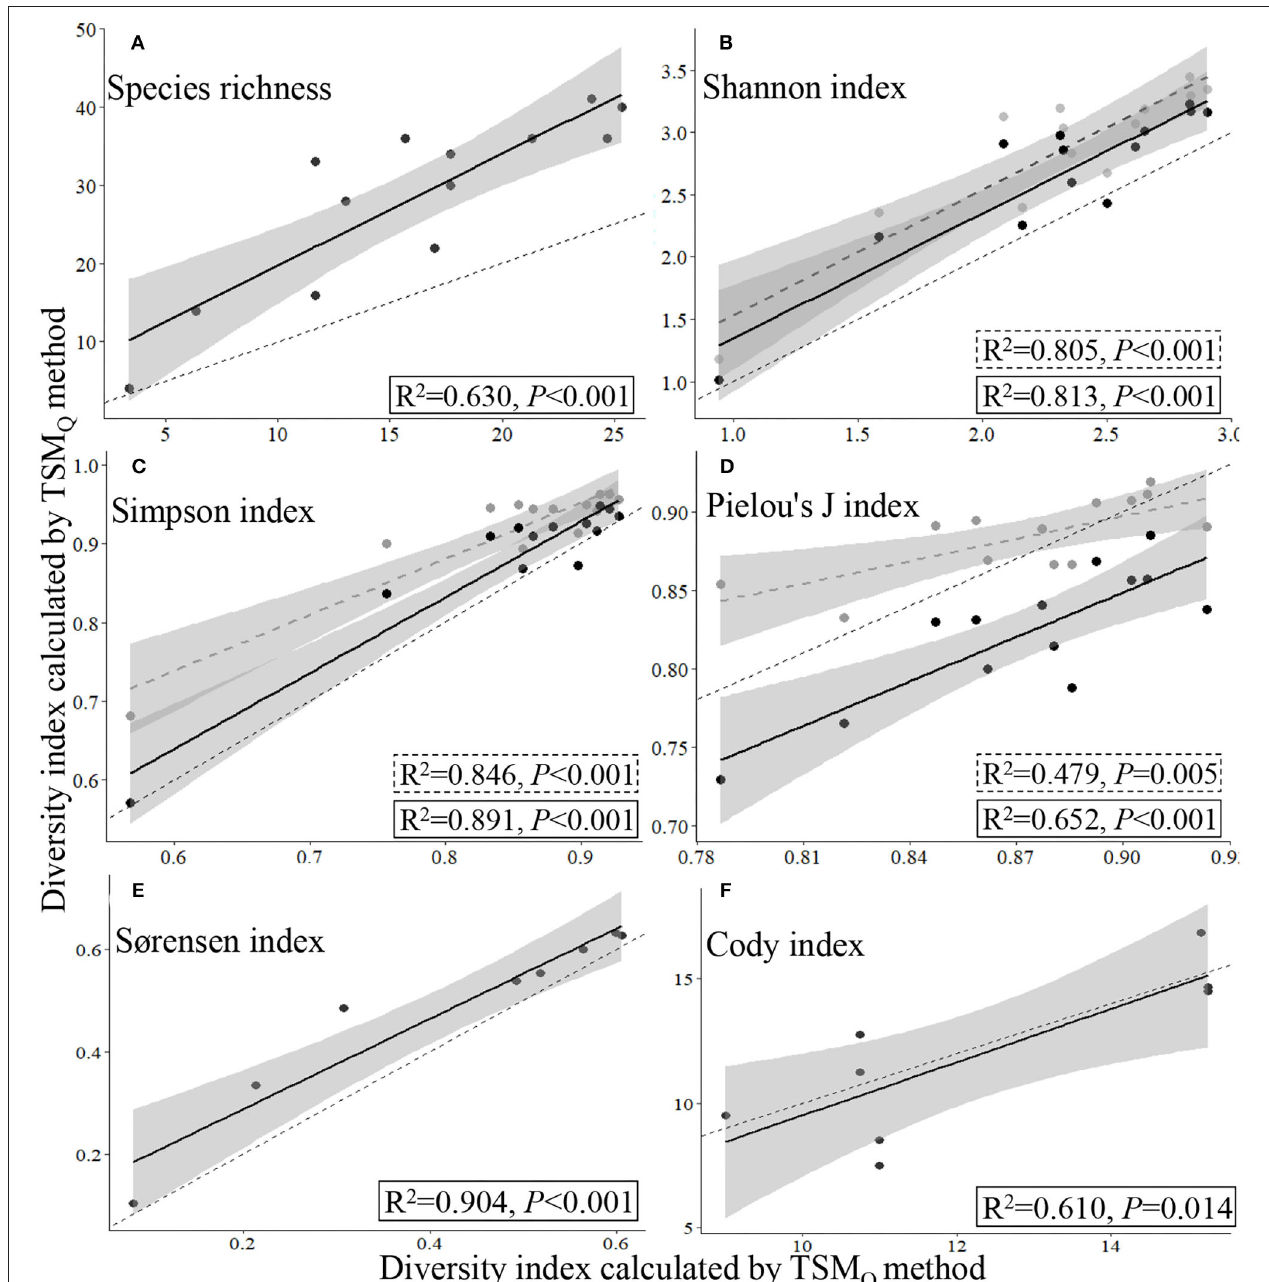
FIGURE 4 | Relationships of α - (A–D) and β -diversity indices estimated (E,F) by the traditional quadrat-based (TSM Q ) and UAV-based (UAV B ) methods. The gray circles and dashed regression lines indicate the presence-based method (UAV B ), while the black circles and full regression lines indicate the dominance-based method (UAV BD ) to the α -diversity indices; the thin dashed line represents the 1:1 line.